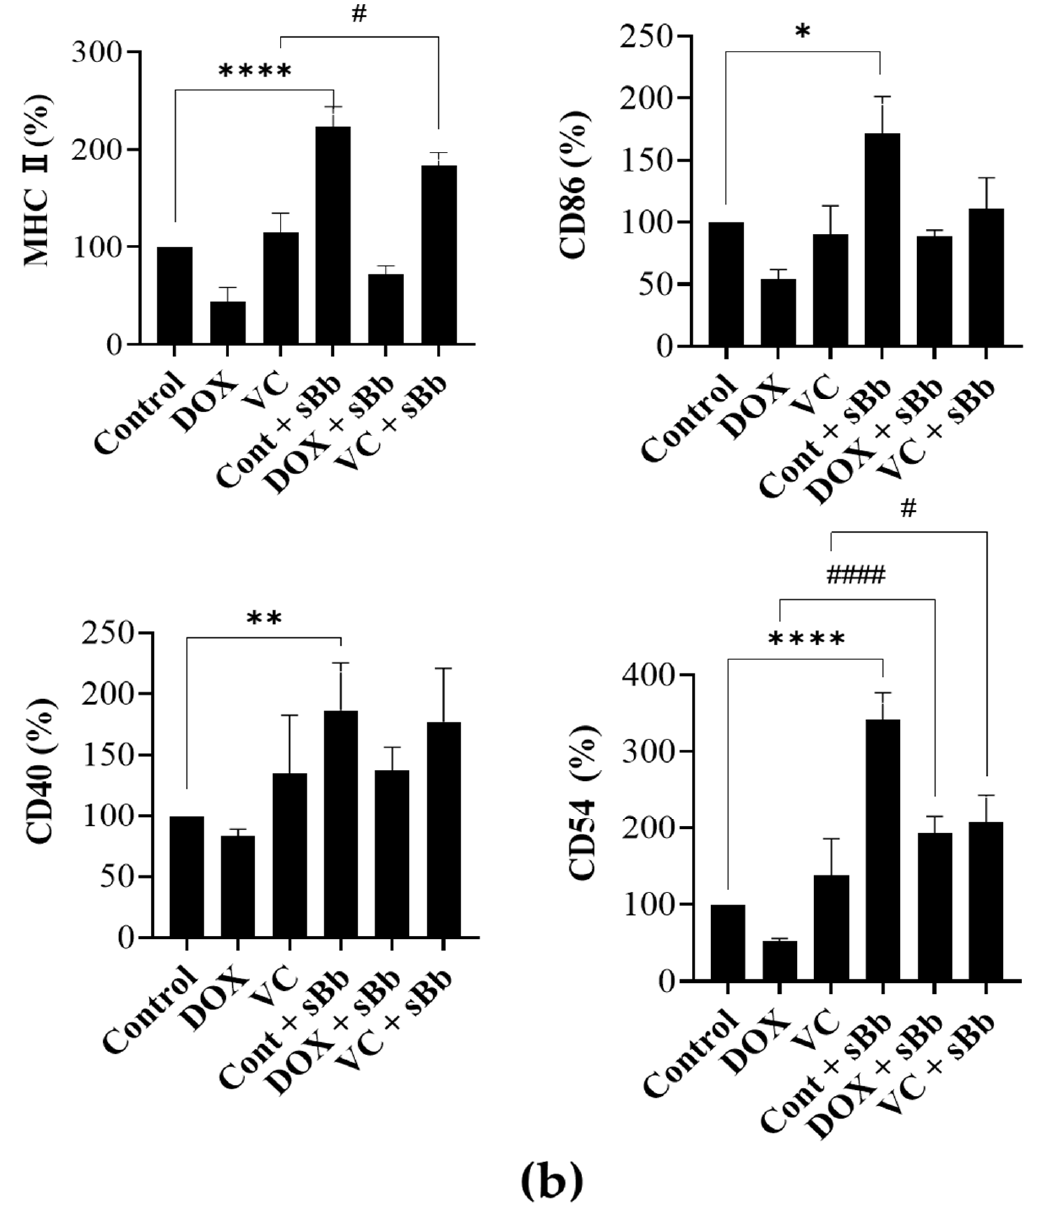
Figure 4. sBb differentially up-regulates the expression of surface markers on DCs. The DCs treated with DOX, VC, and/or sBb were stained with specific antibodies in the presence of Fc blocker and then analyzed by flow cytometry, as described in the Materials and Methods. ( a ) A representative histogram set was presented. Numbers in the upper part of histograms indicate mean fluorescence intensity. ( b ) The graph was generated from 3 independent experiments. The mean fluorescence intensity of control DCs was set at 100%. *, **, and **** indicate p < 0.05, 0.01, and 0.0001 compared to control DCs, whereas #, #### indicate p < 0.05, p < 0.0001 compared to the treated DCs in the absence or presence of sBb.